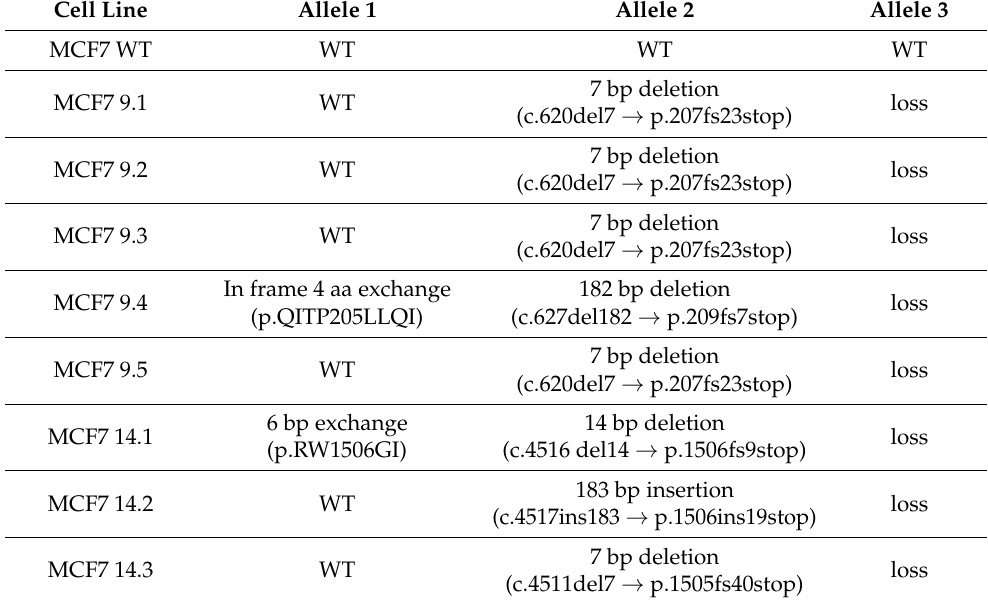
Table 1. BRCA1 Mutations introduced in MCF7 cells via